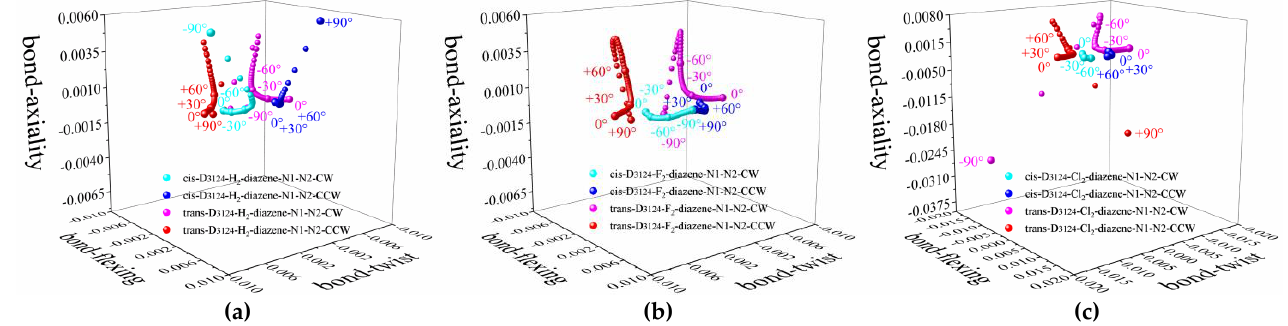
Figure 1. The torsion C1-C2 BCP stress tensor trajectories T σ ( s ) for the Cartesian clockwise (CW) and counter-clockwise (CCW) torsion directions for the geometric cis- and trans- isomers of H 2 -ethene, F 2 -ethene and Cl 2 -ethene are presented in sub-figures (a-c) , respec- tively; see Table 1. Notice the markers at 30° intervals. Table 1. The U σ -space bond cross-section sets {bond-twist T σ , bond-flexing F σ } of the torsion C1-C2 BCP, and the sum ∑{T σ ,F σ }, of ethene and the cis- and trans-isomers of doubly substituted ethene.